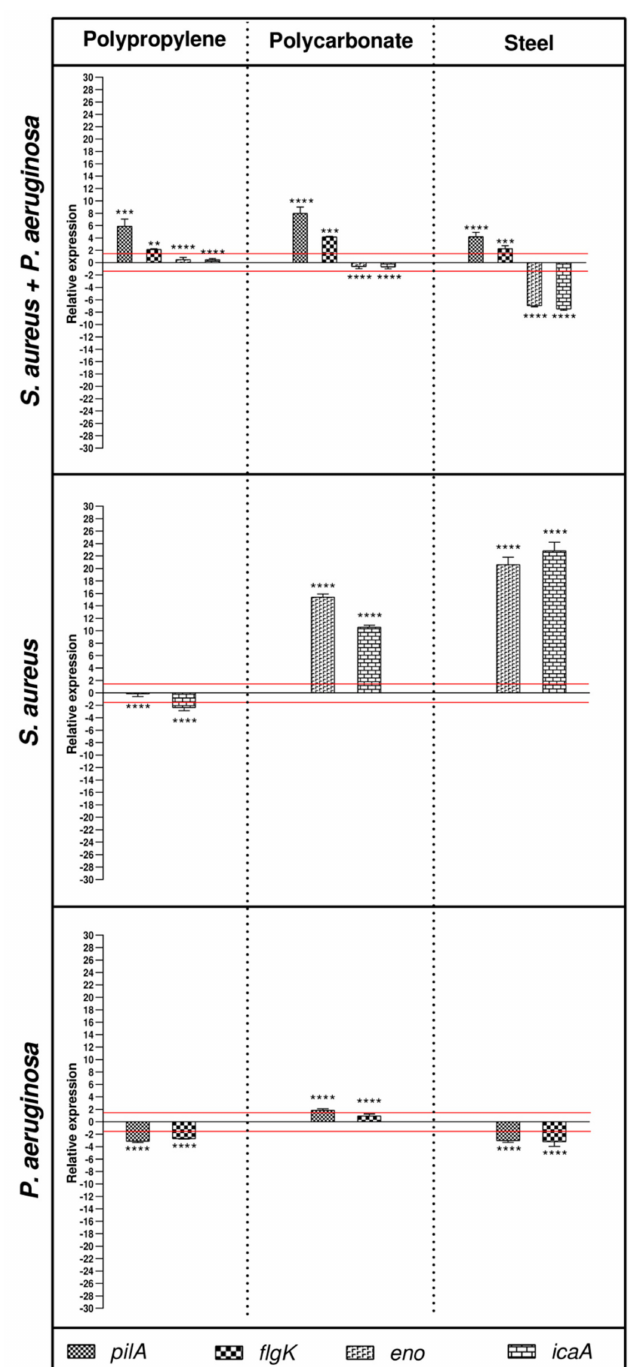
Figure 3. Real-time qPCR at 24 h of treatment. Histograms show the differences in the expression levels of 4 genes involved in biofilm formation and cell-cell communication. Bacterial biofilm was grown in the presence of limonene at sub-MIC concentration. Fold differences greater than ± 1.5 (see red dotted horizontal guidelines at values of +1.5 and − 1.5) were considered significant (see Table 3 for the values). Sisak’s test (**** p < 0.0001; *** p < 0.001; ** p <